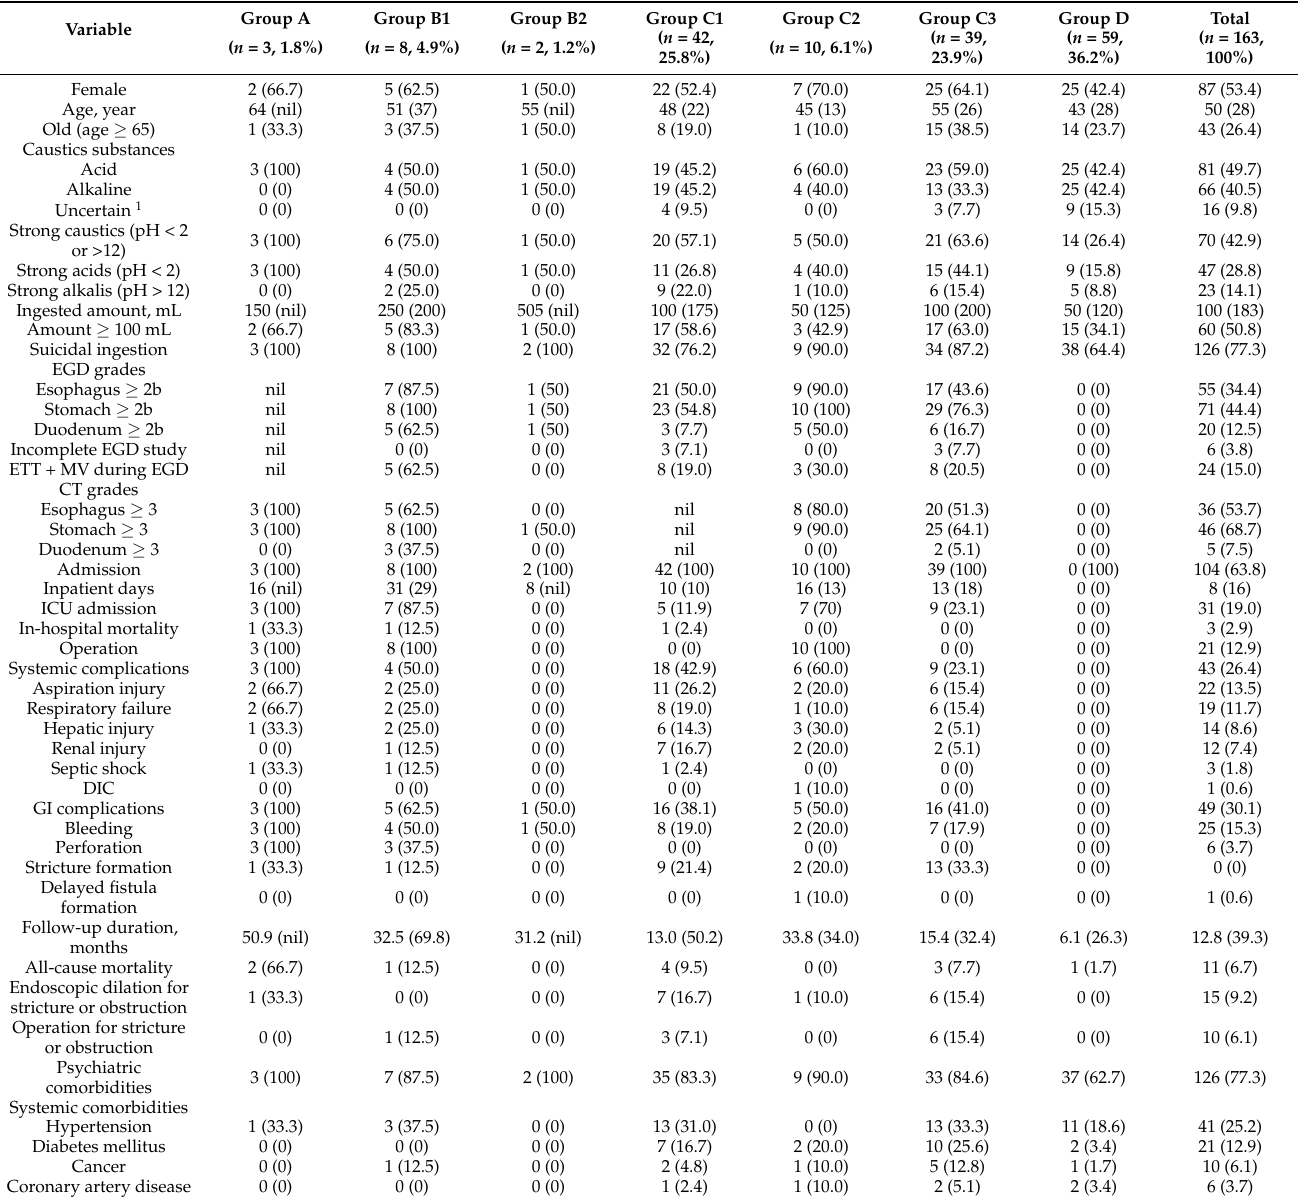
Table 1. Comprehensive demographic profiles of each group of